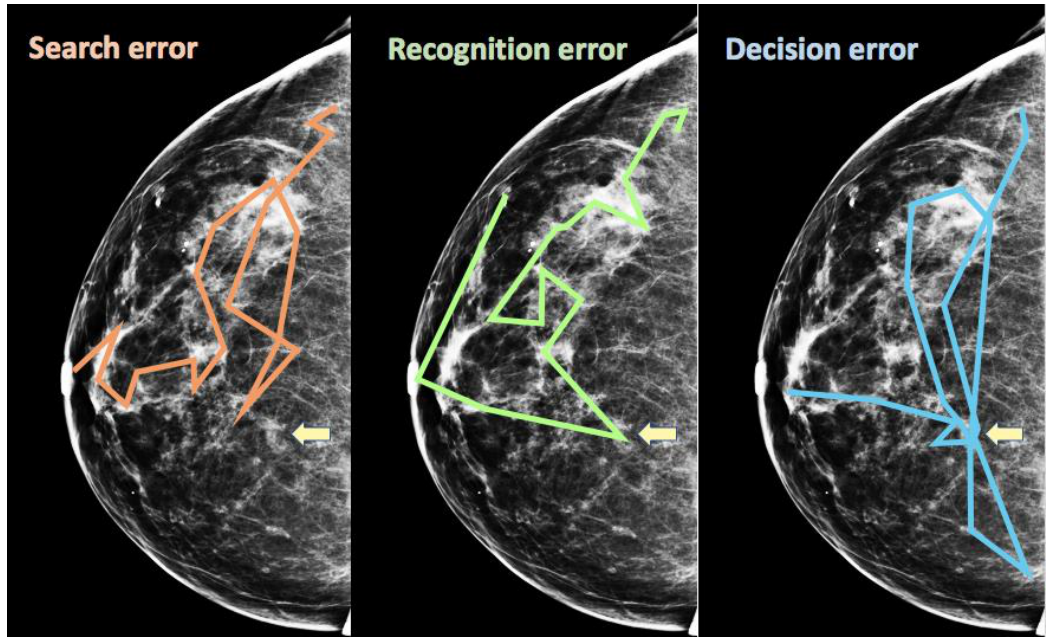
Figure 5. Three types of false negative (miss) errors, as proposed by Kundel and colleagues.